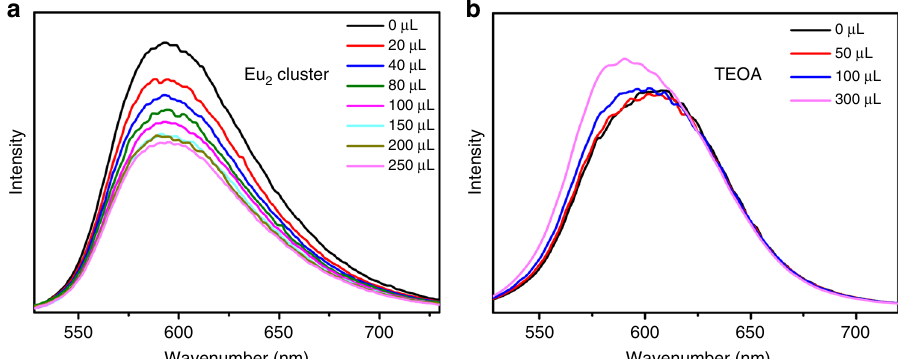
Fig. 7 Fluorescence quenching. a Emission spectra of H 3 L after the addition of different amounts of [Eu 2 (MMA) 6 (H 2 O) 4 ] and b TEOA in DMF with 465 nm